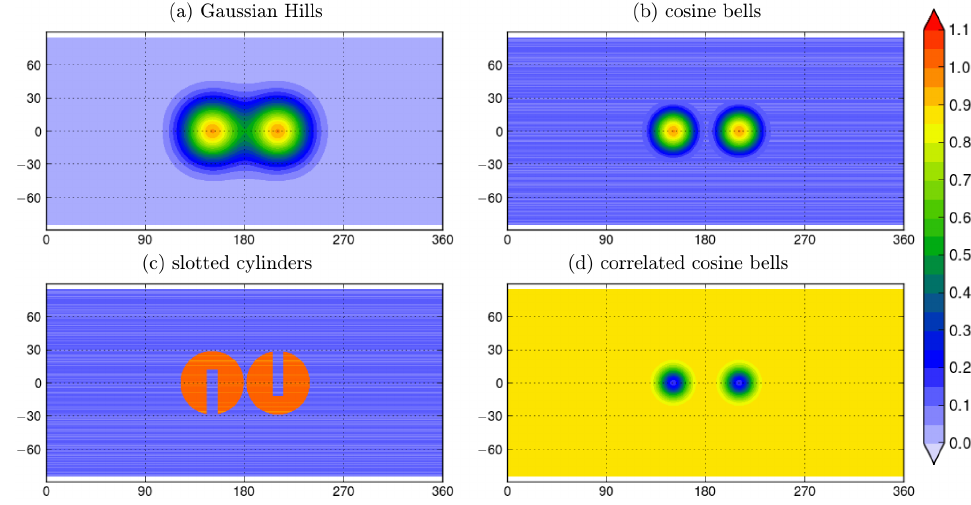
Figure 8. Initial shapes of the puffs for the 2-D global test on the